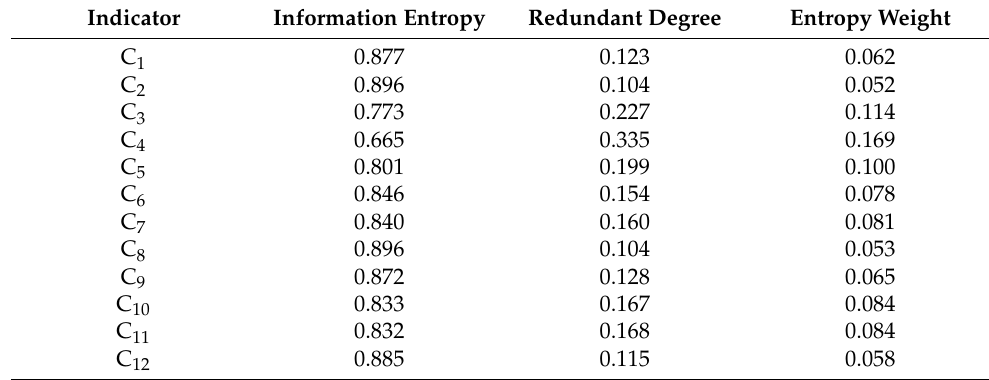
Table 3. Weights of